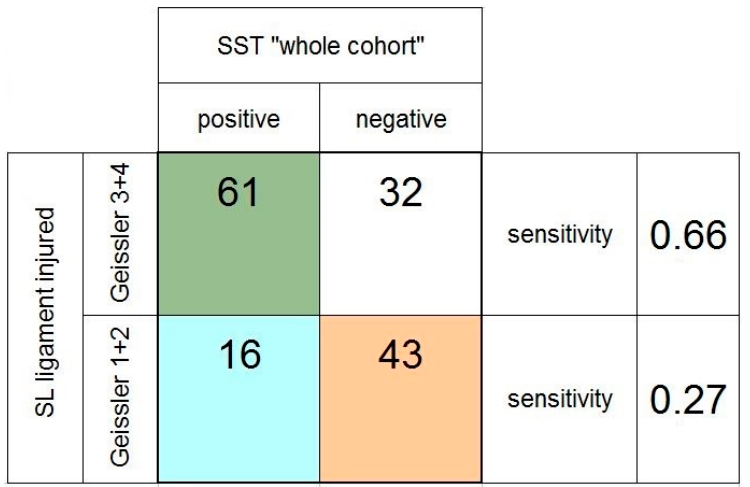
Figure 5. Fourfold table of the scaphoid shift test (SST) in the whole cohort of patients, depending on the severity of the scapholunate (SL) ligament injury (grade 1 + 2 vs. grade 3 + 4, according to the Geissler classification).